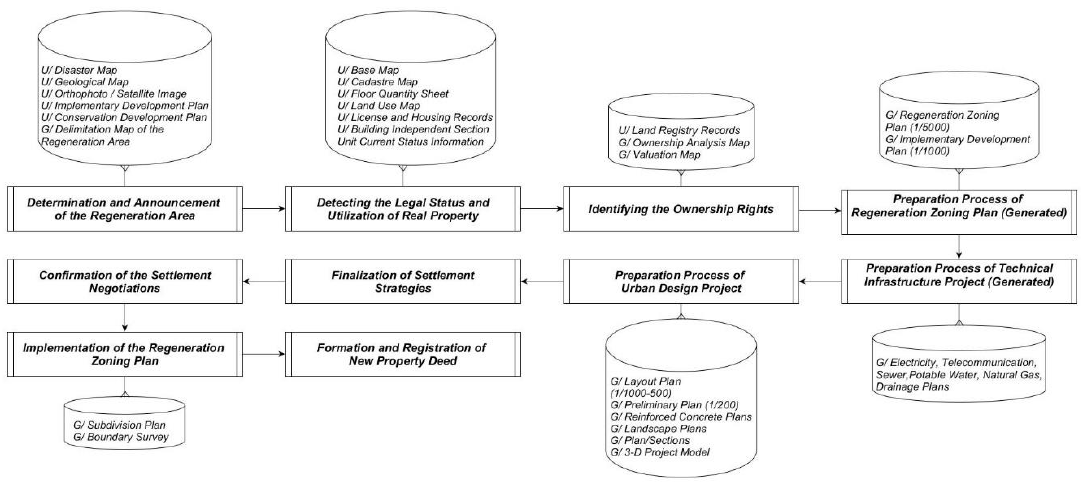
Figure 5. Spatial Data Infrastructure in Urban Regeneration Studies .